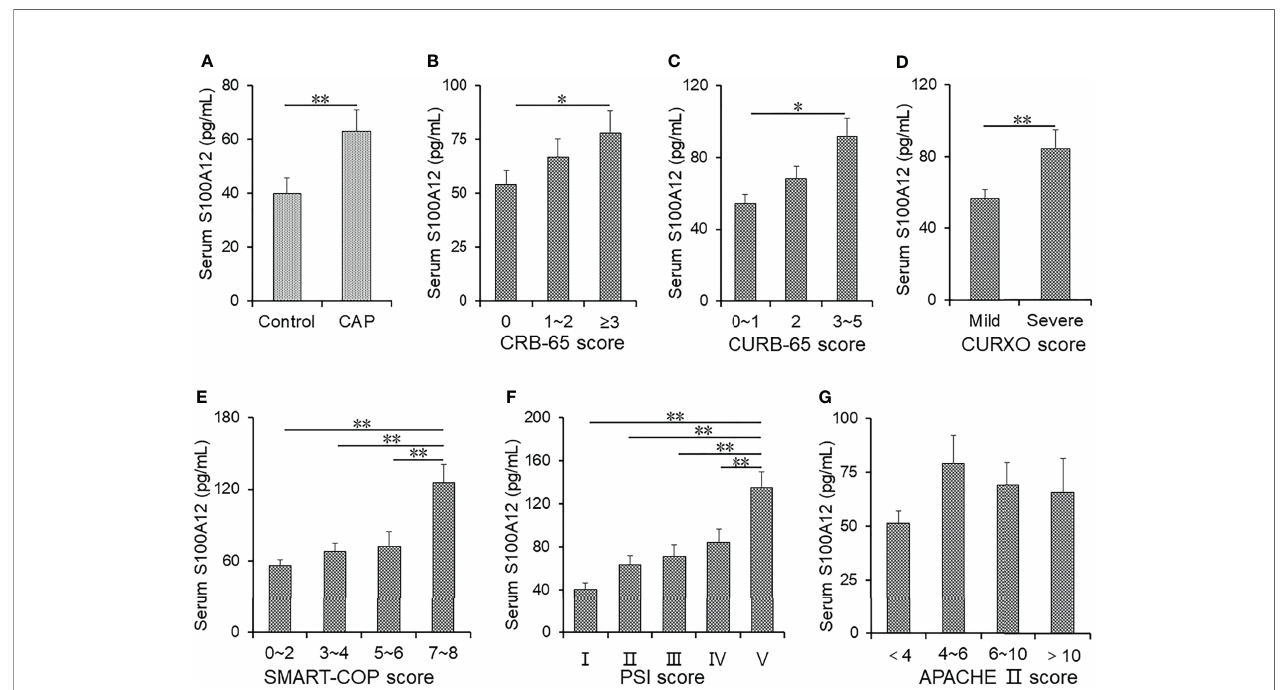
FIGURE 1 | The levels of serum S100A12 in control groups and CAP patients. (A – G) The level of serum S100A12 was measured with ELISA. (A) The level of serum S100A12 in CAP patients and control cases. (B) The level of serum S100A12 in different CRB-65 score of CAP patients. (C) The level of serum S100A12 in different CURB-65 score of CAP patients. (D) The level of serum S100A12 in different CURXO scores of CAP patients. (E) The level of serum S100A12 in different SMART- COP scores of CAP patients. (F) The level of serum S100A12 in different PSI scores of CAP patients. (G) The level of serum S100A12 in different APACHE II scores of CAP patients. Data were expressed as mean ± SEM. * p < 0.05, ** p < 0.01.